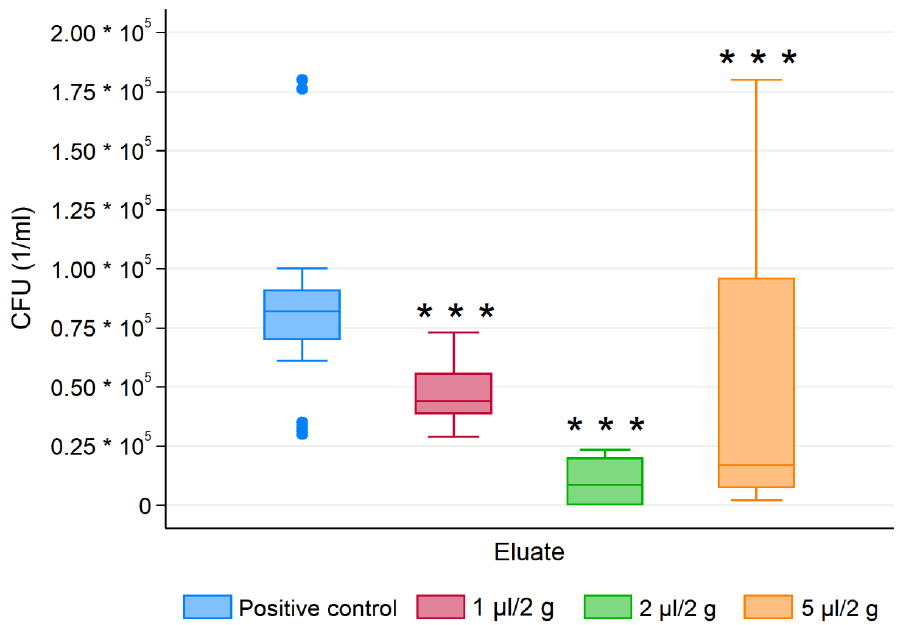
Figure 7. Colony forming units (CFU) of C. albicans for essential oil modified composite resins and the control group. *** p < 0.001 versus control.